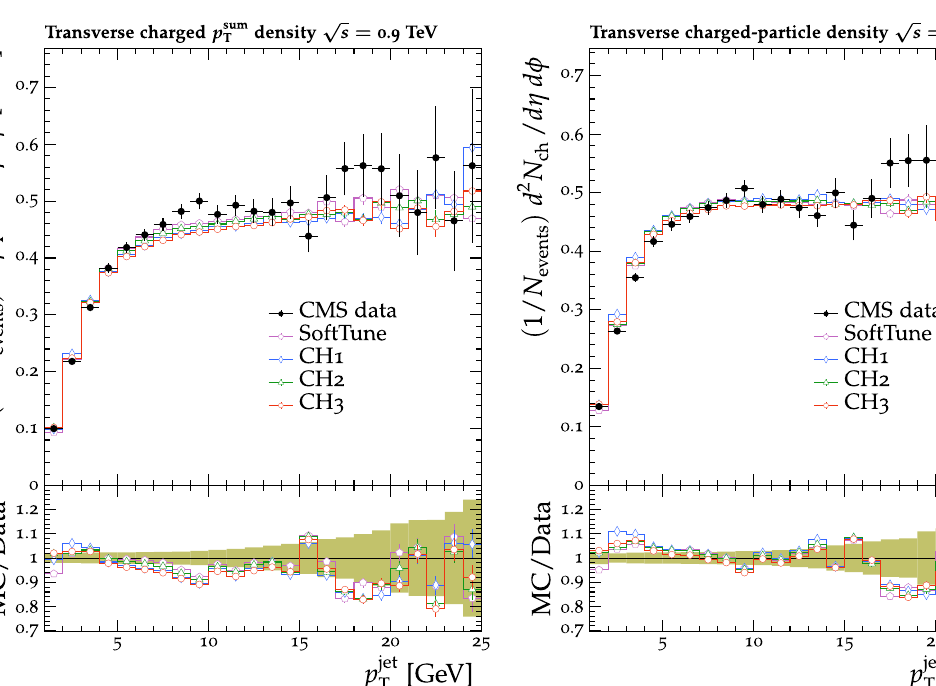
sents the total experimental uncertainty in the data. The vertical bars on the points for the different predictions represent the statistical uncer- [25]. T